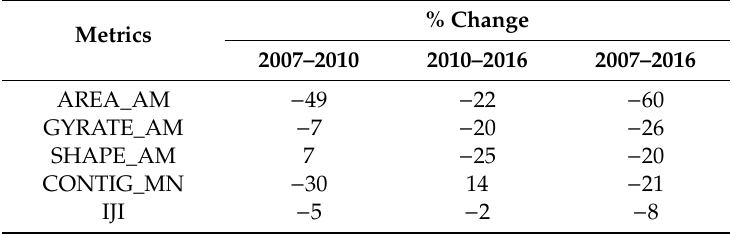
Table 5. Pattern metrics changes in landscape level